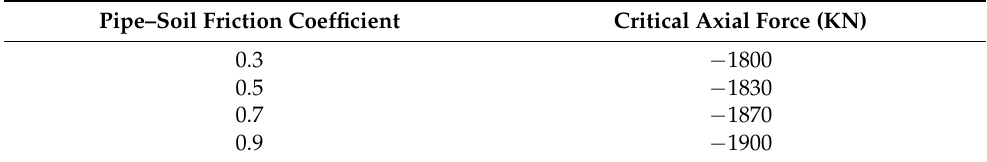
Figure 6. Influence of the pipe – soil friction coefficient in the axial force – lateral displacement graph. Table 4. Critical axial force of pipe–soil friction coefficient.